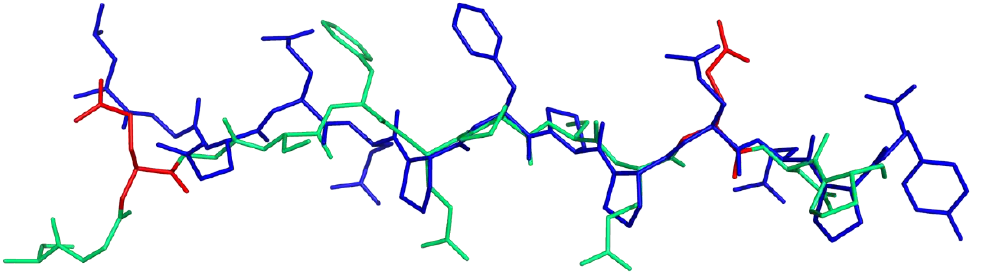
Figure 8. Superposition of DQ8-glia- α 1 (from binary complex PDB code 2NNA, colored in green with Glu residues at P1 and P9 colored in red) with P31–43 modelled in PPII structure (blue).